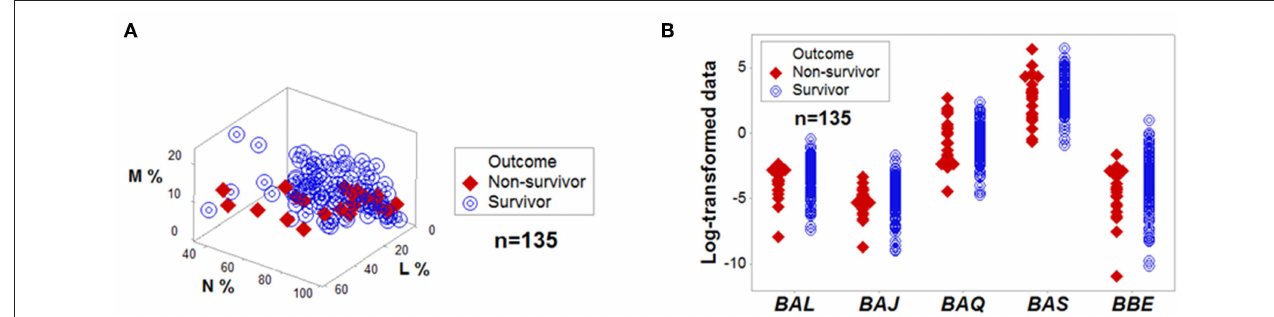
FIGURE 1 | No variable, per se , is discriminant. Directly measured variables, such as the relative percentages of lymphocytes (L), monocytes (M), and neutrophils (N) did not separate outcomes of hantavirus-infected humans when measured in 3D space (A) . Complex and dimensionless variables (here identified as BAL, BAJ, BAQ, BAS , and BBE ) also showed overlapping data distributions when survivors and non-survivors were measured (B) . The median L, M, and N percentages, as well as the median BAL, BAJ, BAQ, BAS , and BBE of survivors did not differ at a statistically significant level from those of non-survivors ( P > 0.10, Mann-Whitney